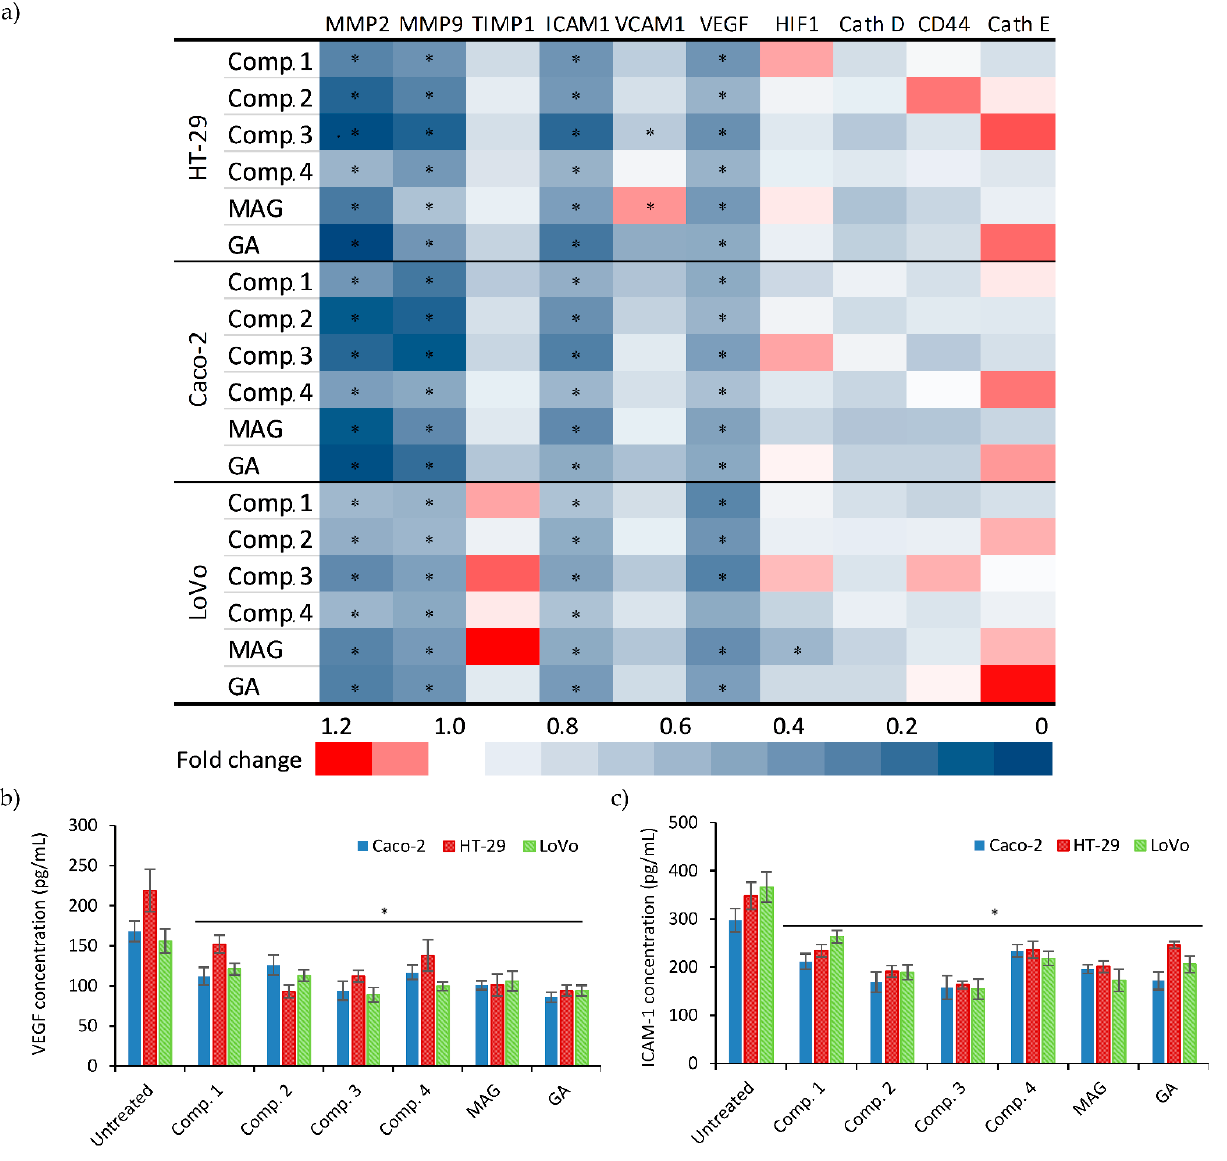
Figure 4. ( a ) Effect of xanthone treatment on the change in expression of selected genes evaluated by real-time RT-PCR assays performed in Caco-2, HT-29, and LoVo cell cultures after xanthone treatments. Results of ELISA indicating changes in ( b ) VEGF and ( c ) ICAM-1 concentration after treatment with corresponding compounds. Graphs present median (+/ − S. D.) values; * indicates a significant difference ( p < 0.05) vs. untreated controls.